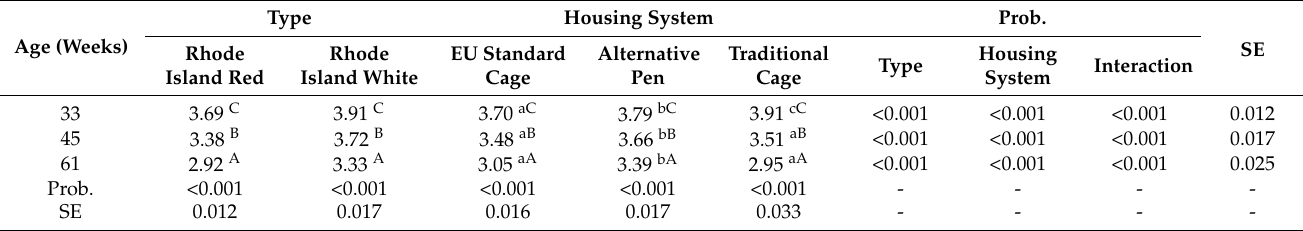
Table 7. Effect of type and housing system on the plumage points on the remiges of non-beak-trimmed Rhode Island